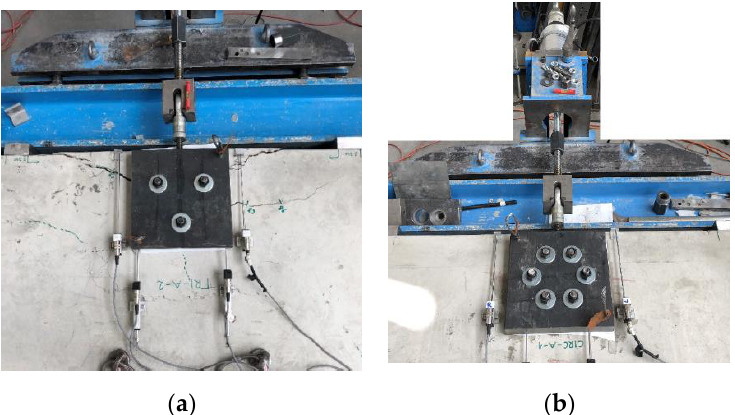
Figure 2. Test setup used by Bokor et al. [12] for conducting shear tests on anchorages of ( a ) triangular configuration and ( b ) hexagonal configuration (photos by author).